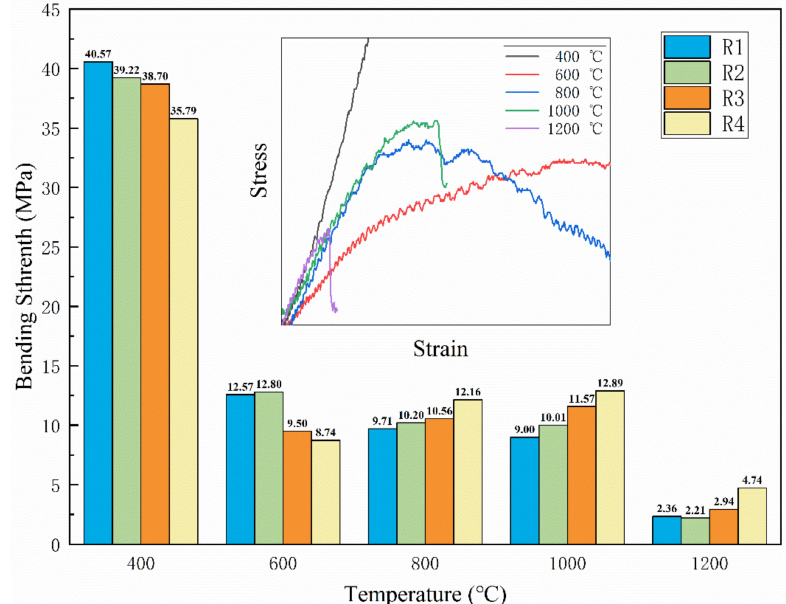
Figure 4. Bending strength of R1–R4 after static ablation at different